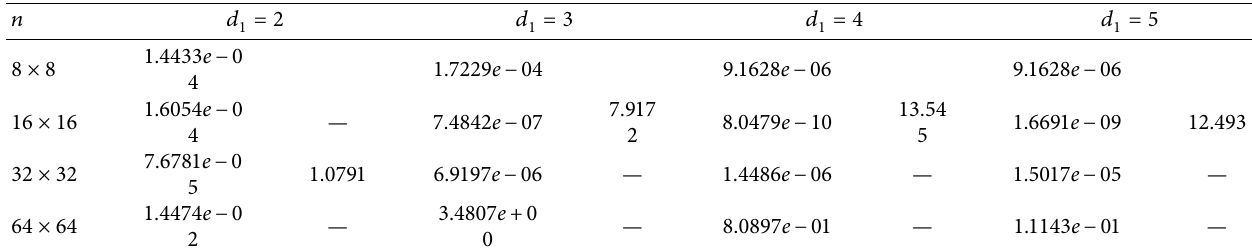
Table 4: Convergence rate of quasi-equidistant nodes with different d